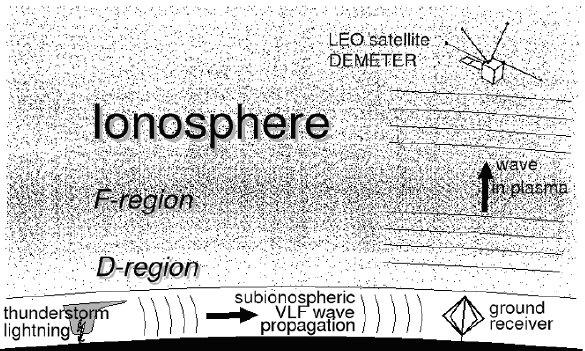
Fig. 6. Schematic of tweek generation in the EIWG and a sub- sequent fractional hop whistler propagation across the inhomoge- neous ionosphere to a LEO satellite.